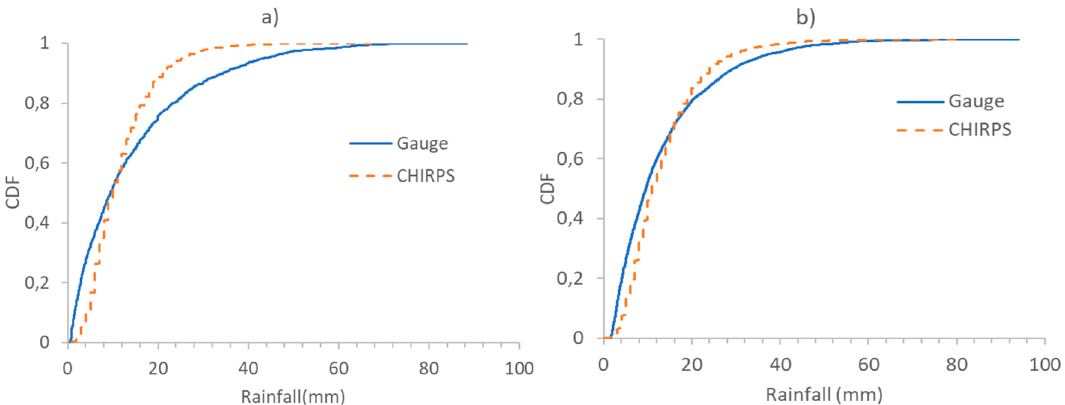
Figure 3. Daily Rainfall Cumulative Distribution Functions (CDFs) of CHIRPS estimates and gauge measurement: ( a ) for low land stations and ( b ) for highland station of the Beles Basin during 2005–2015.